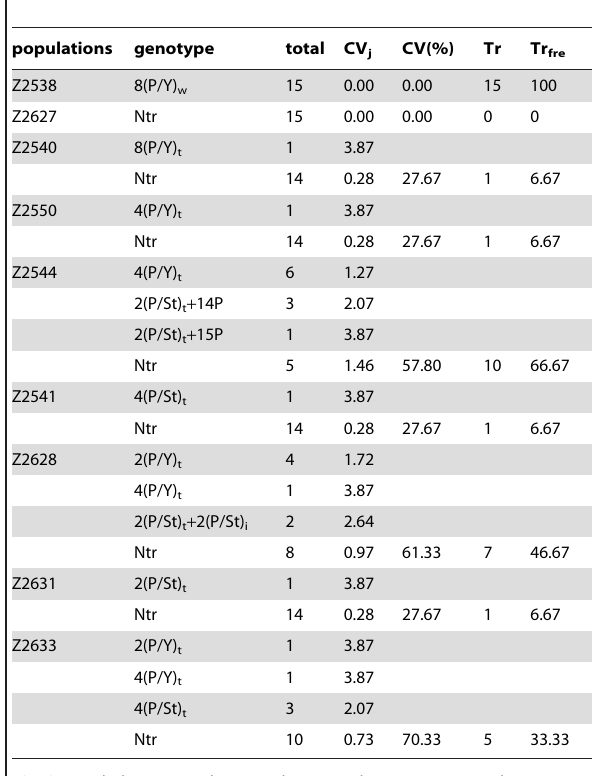
Table 2. Types and frequencies of chromosome translocation in nine populations of K. thoroldiana .